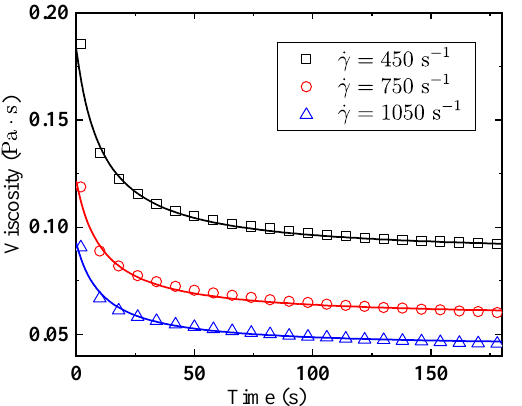
Figure 6. Measured (plotted in markers) and model-calculated (plotted in lines) viscosity of kerosene gel with 5% organic gellant at different shear times. Table 2. Fitted parameters of the second-order thixotropic model based on Equation (8).